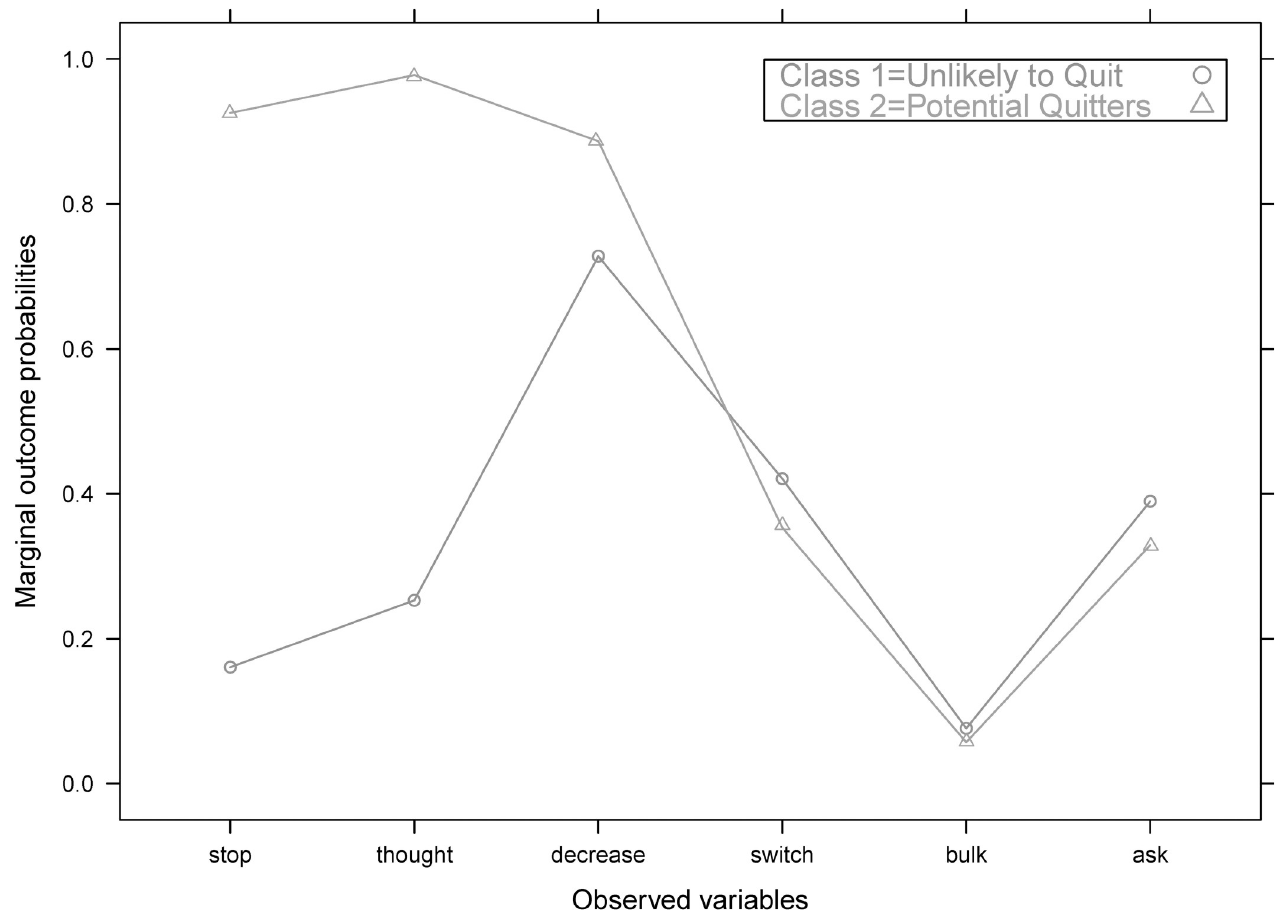
Fig 1. Marginal outcome probabilities by type of smoker.